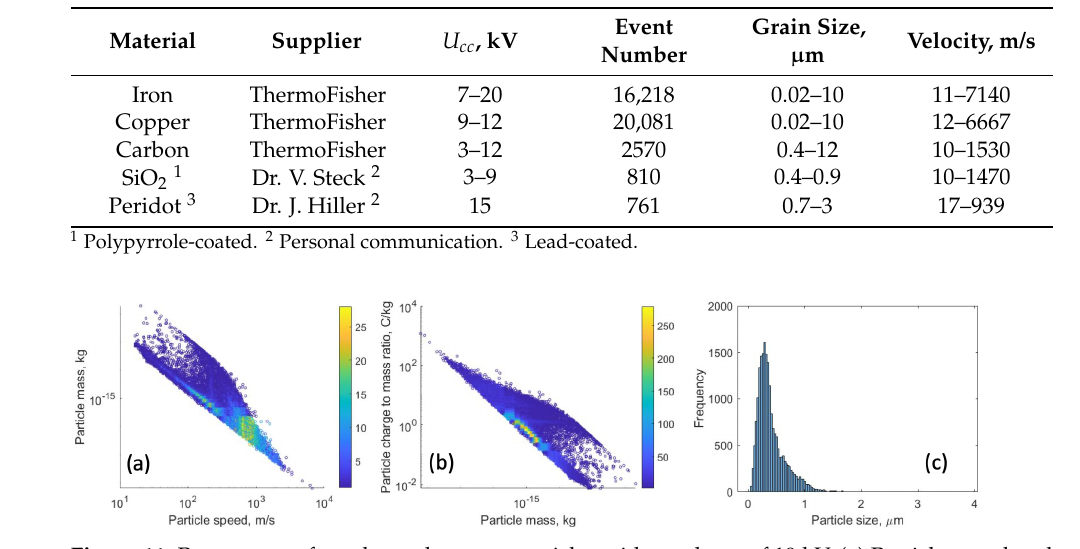
Table 4. Parameters of accelerated dust particles at the small dust accelerator.